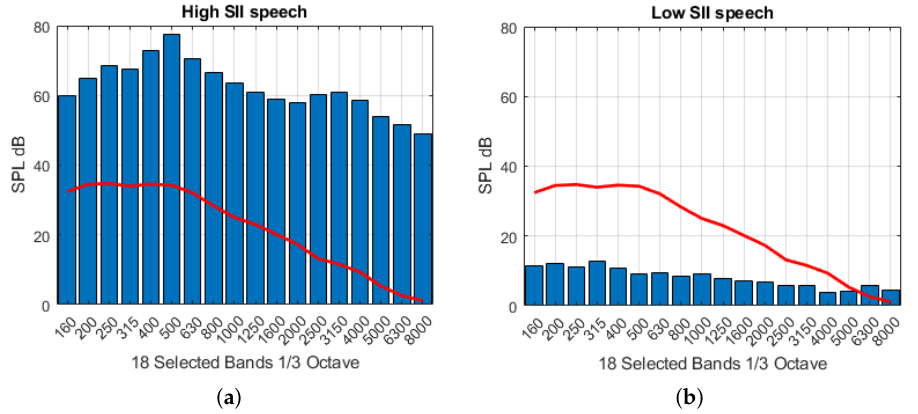
Figure 6. 18-band spectrum needed for SII computation for: ( a ) excellent intelligibility and ( b ) bad intelligibility. Equivalent hearing threshold levels T i for normal speech as the overlapping line